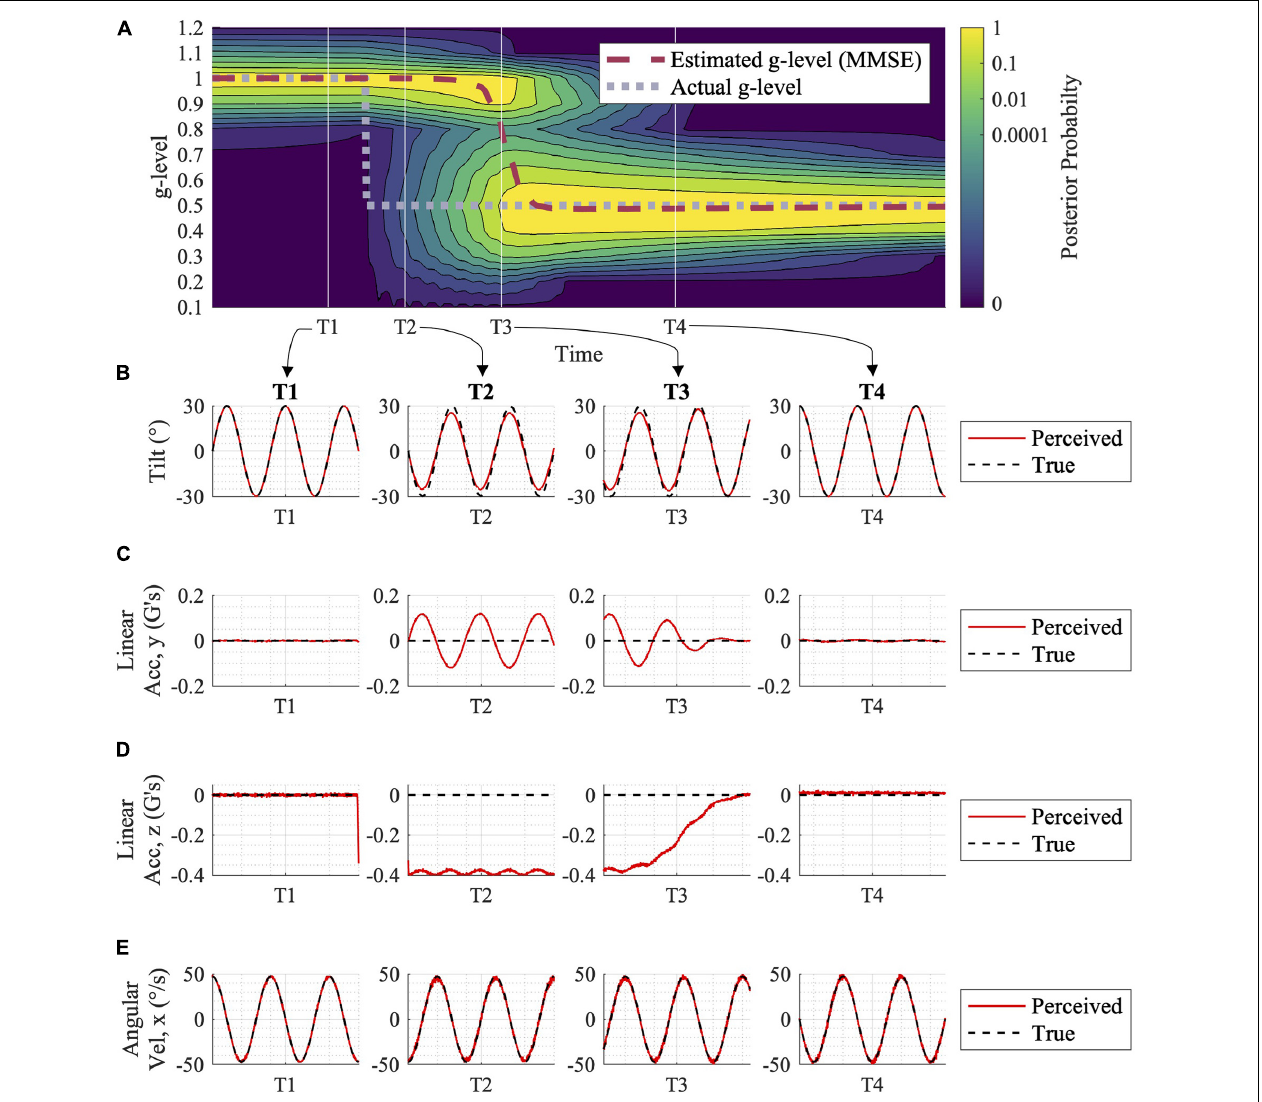
FIGURE 3 | Adaptation to gravity transition with associated expected tilt, acceleration, and angular velocity perceptions. (A) The motion profile utilized in this simulation was a sinusoidal, head-centered roll-tilt at 30 ◦ amplitude and 0.25 Hz frequency. Following a shift in gravity from 1 to 0.5 g (gray dashed line in A ), the posterior probability distribution shifts, and the central estimator adjusts to the new gravity level over time (red dashed line). This adaptation process is driven by sensory conflict signals for each alternative hypothesis for the internal magnitude of gravity (not shown here, but see Supplementary Figure 1 ). At time points T1, T2, T3, and T4, (B–E) show the Central Observer Model-predicted perceived (red) vs. true (black) (B) tilt, (C) linear acceleration (y component), (D) linear acceleration (z component), and (E) angular velocity (x component, as the others are essentially zero). While at T1, prior to the gravity transition, motion is accurately perceived. Misperception occurs at times T2 and T3 (albeit, less misperception) while the model is undergoing the adaptation process. By T4, when the adaptation is complete, motion is accurately perceived in 0.5 g